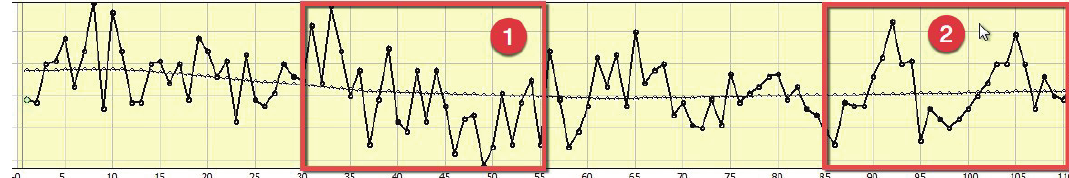
Figure 1: Example of the analysis of a real time series using F-transform: trend of the time series and its evalu- ation with respect to the context w DTr = (cid:6) 0 , 860 , 2150 (cid:7) that was determined from the largest difference of values over 12 months. The trend was estimated using Theorem 2 by specifying the periodicity T = 51 that is the longest periodicity detected by periodogram. Two rectangles mark areas in which local trend was linguistically evaluated using coefficients (4) as follows: 1 — clear decrease and 2 — negligible increase . Trend of the whole time series is stagnating